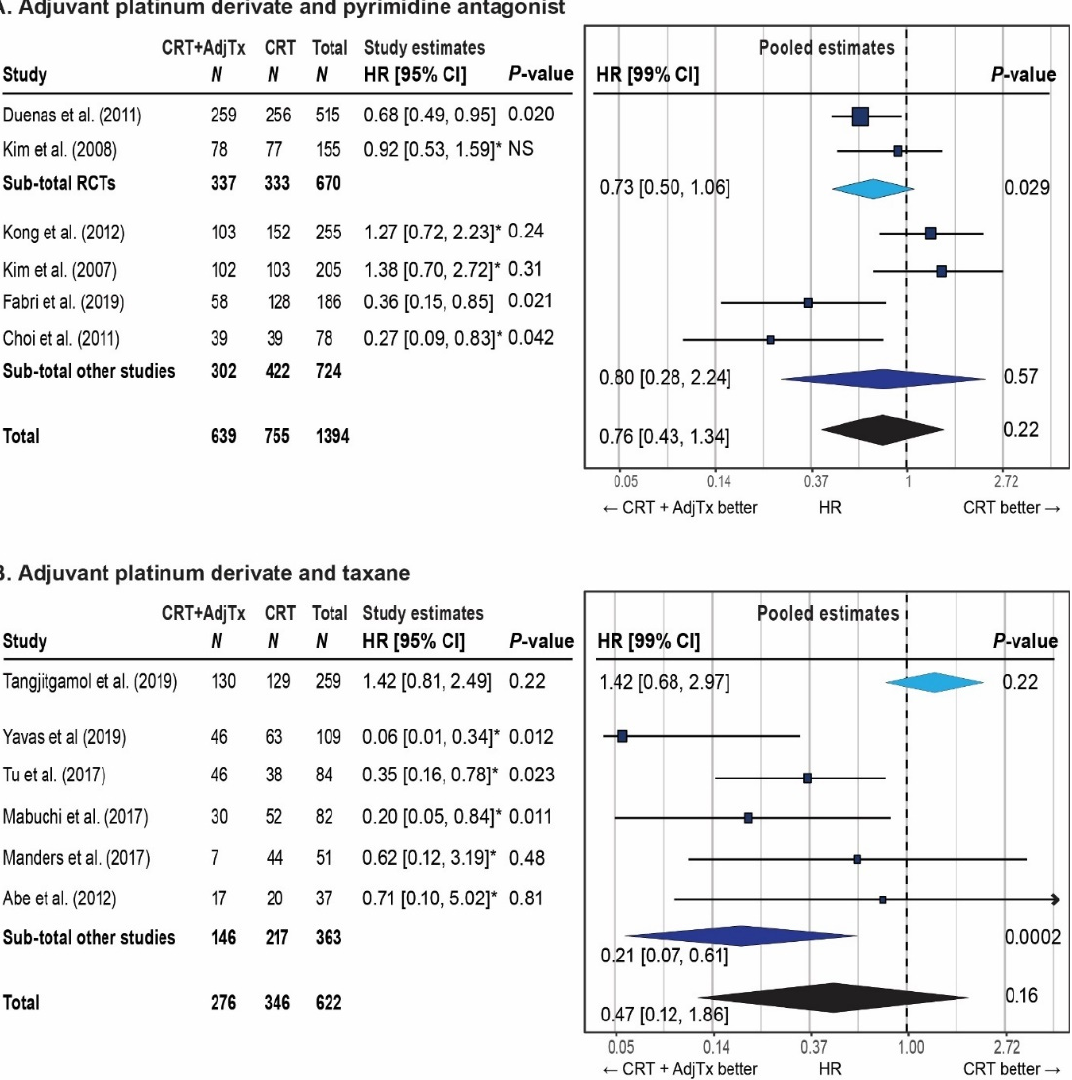
Figure 3. Impact on the overall survival of the addition of adjuvant chemotherapy to chemoradiation and brachytherapy. Each study in the forest plot is represented by a black square which represents the study’s hazard ratio and a whisker on each side that represents the study’s 99% confidence interval. The size of the black square represents the weight of the study in the meta-analysis. The pooled hazard ratios are shown as diamond shapes; the light blue diamond represents the pooled hazard ratio based on only randomized controlled trials, the dark blue diamond represents the pooled hazard ratio based on only non-randomized studies, and the black diamond is the pooled hazard ratio of all studies combined. ( A ) Meta-analysis of overall survival after concurrent chemoradiation and brachytherapy with adjuvant platinum derivate and pyrimidine antagonist vs. concurrent chemoradiation and brachytherapy only. I 2 = 62%, Q-test p = 0.02. ( B ) Meta-analysis of overall survival after concurrent chemoradiation and brachytherapy with adjuvant platinum derivate and taxane vs. concurrent chemoradiation and brachytherapy only. I 2 = 74%, Q-test p = 0.002. Definition of abbreviations: CRT = chemoradiation and brachytherapy; AdjTx = adjuvant therapy; HR = hazard ratio; CI = confidence interval. * Imputed values; methods described in Supplementary Materials